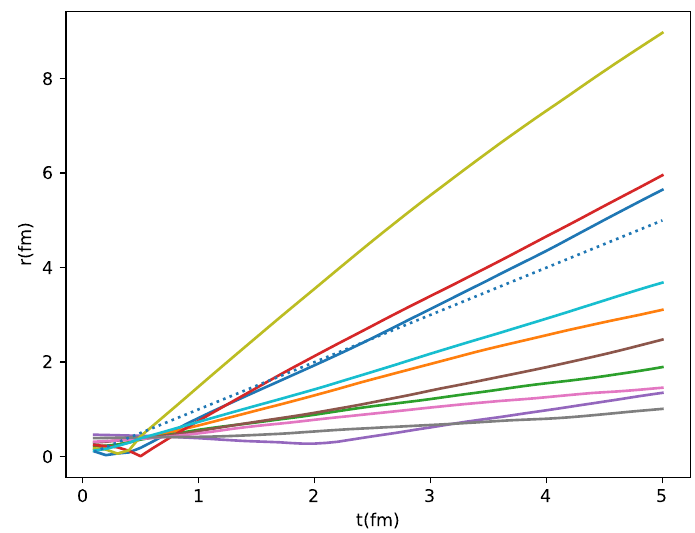
Figure 7 . Example of ten random trajectories for the relative distance of a bottom quark-antiquark pair prepared in a 1 S bound state. About half of these trajectories are unphysical, since they correspond to supraluminal velocity, r ( t ) > t . To illustrate this we have plotted a dotted line that corresponds to a luminical velocity with r (0) =